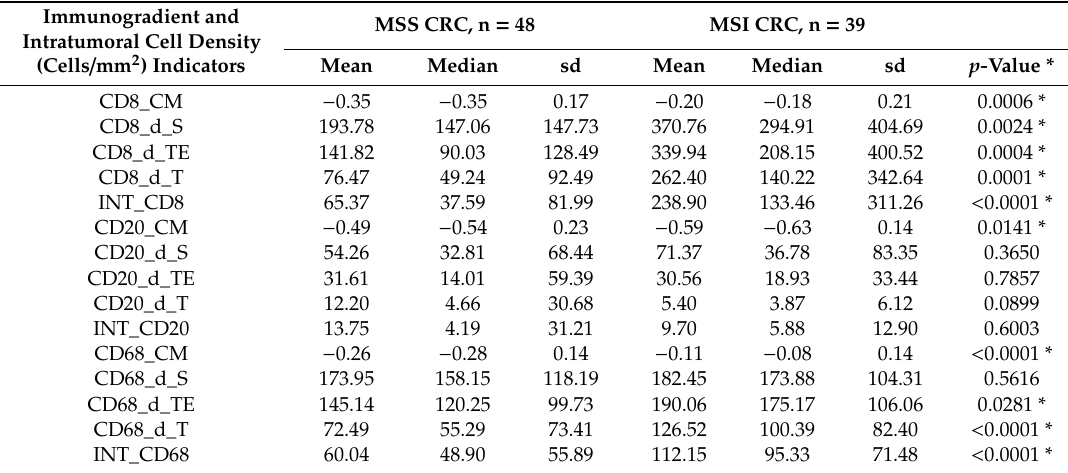
Table 2. Summary statistics of the Immunogradient and intratumoral immune cell density indicators in patients grouped by tumor microsatellite instability